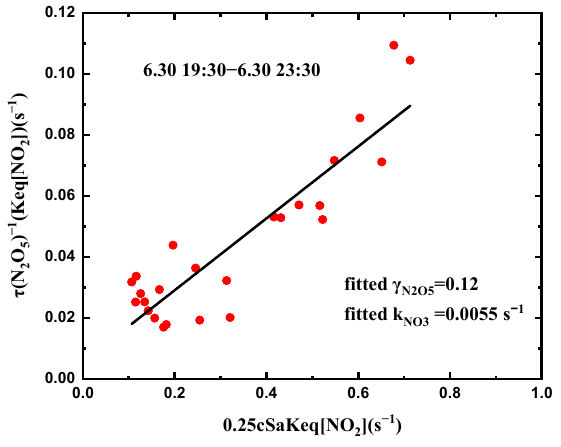
Figure 8. The N 2 O 5 uptake coefficient is the slope of the linear fits of τ ( N 2 O 5 ) − 1 K eq [ NO 2 ] versus 0.25cS a K eq [ NO 2 ] ; k NO is the intercept of the linear fits. 3 The k NO values varied from 0.0028 s − 1 to 0.041 s − 1 , and the average was 0.013 ± 0.016 s − 1 , corresponding to the shorter NO 3 lifetime below 1 min (Table 2). The high k NO3